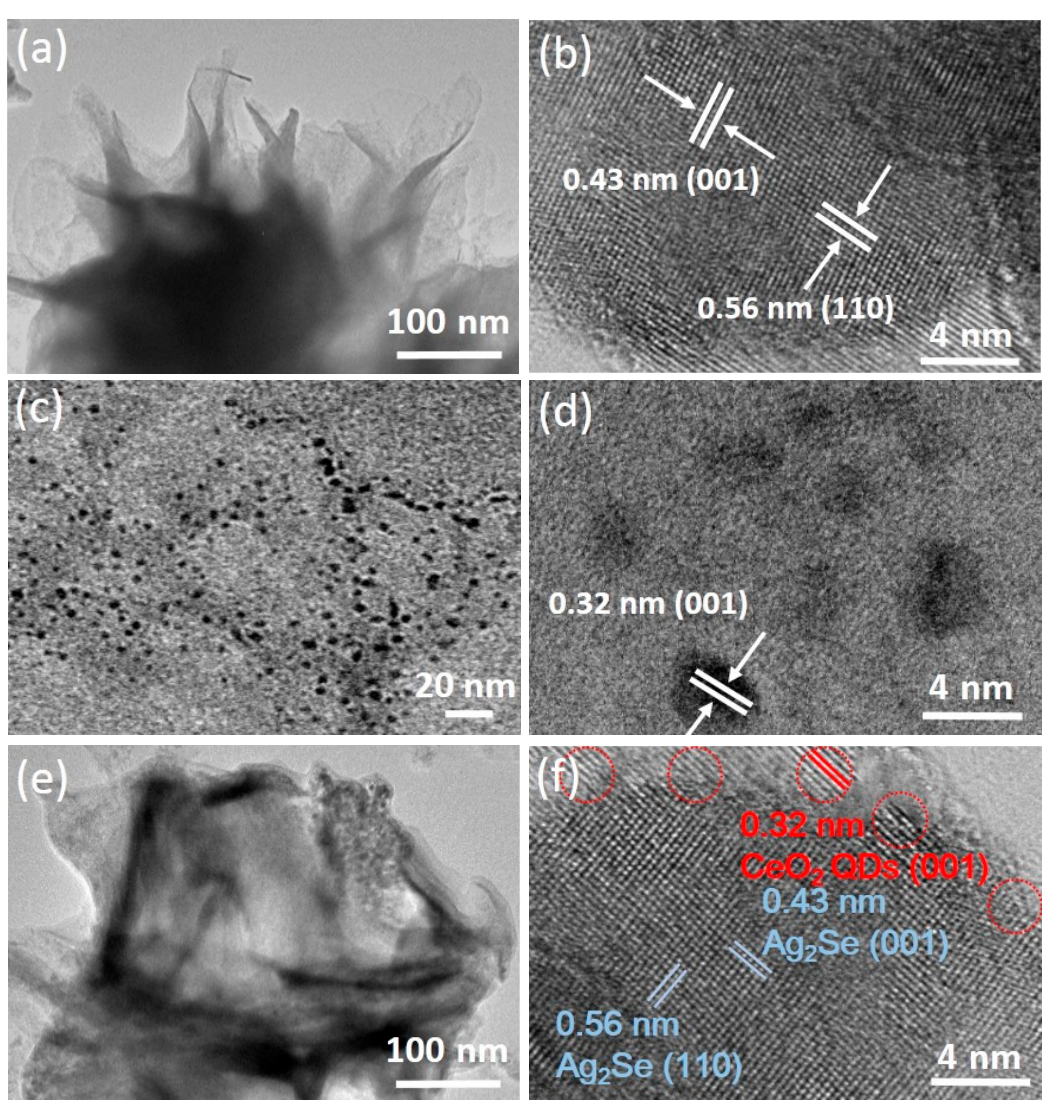
Figure 4. TEM and HR-TEM images: ( a , b ) Ag 2 Se nanoflowers, ( c , d ) CeO 2 QDs, and ( e , f ) 10% CeO 2 QDs/Ag 2 Se Z-scheme nano-heterojunction.